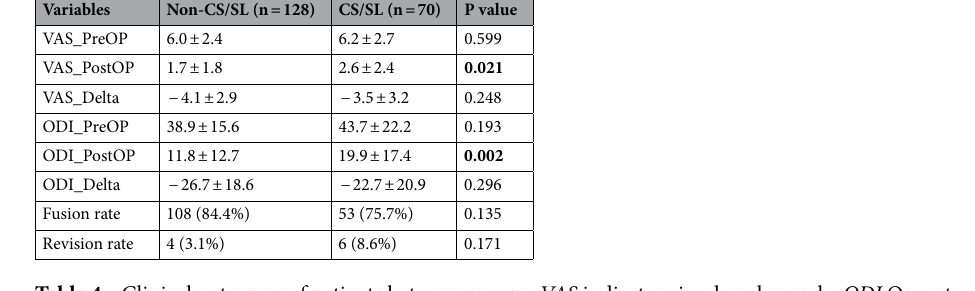
Table 4. Clinical outcomes of patients between groups. VAS indicates visual analog scale, ODI Oswestry disability index, CS cage subsidence, SL screw loosening. Significant values are in bold.